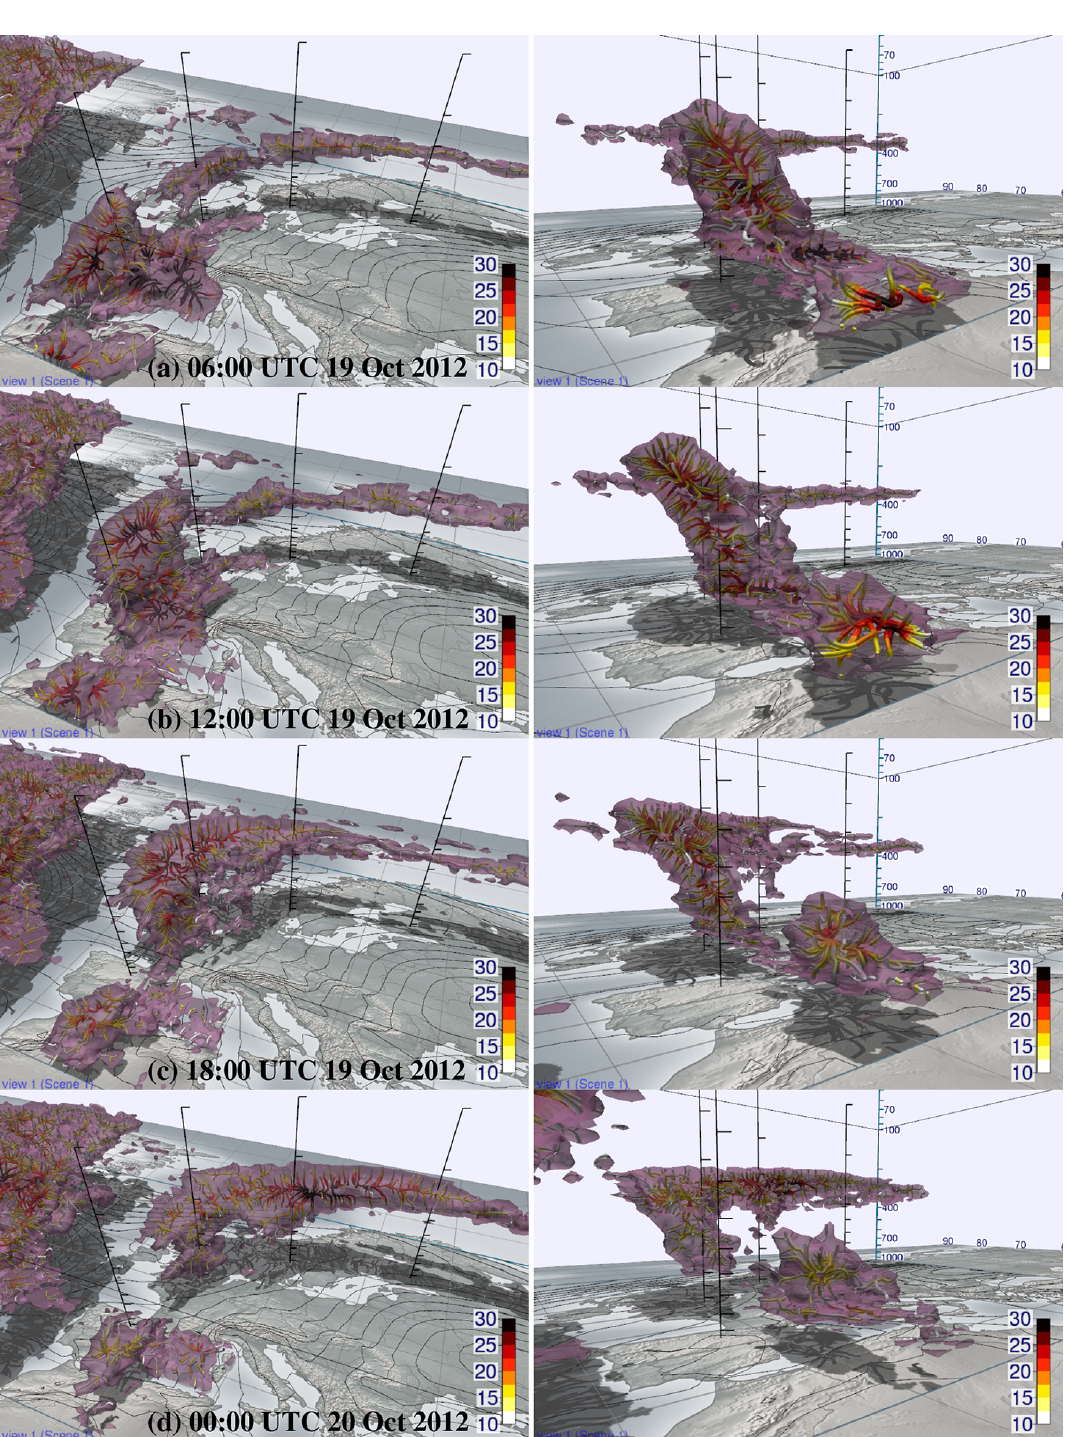
Figure 12. Subsequent time steps of p( WCB ) (computed with DF-T set-up (S3)), rendered from different viewpoints. Forecast from 00:00UTC 15 October 2012, valid at (a) 06:00UTC, (b) 12:00UTC, (c) 18:00UTC, 19 October 2012 and at (d) 00:00UTC, 20 Octo- ber 2012. Trajectory filtering is set to 500hPa in 48h. The purple transparent isosurfaces show a probability of 10%. The interior structure of the isosurfaces is visualized using the 3-D normal curves approach proposed in Part 1, Sect. 3.4. The normal curves follow the gradient of the p( WCB ) field and converge at local maxima. They are coloured by probability (%) to allow one to visually track probability maxima (red to black convergence zones). Black surface contour lines show ensemble mean sea level